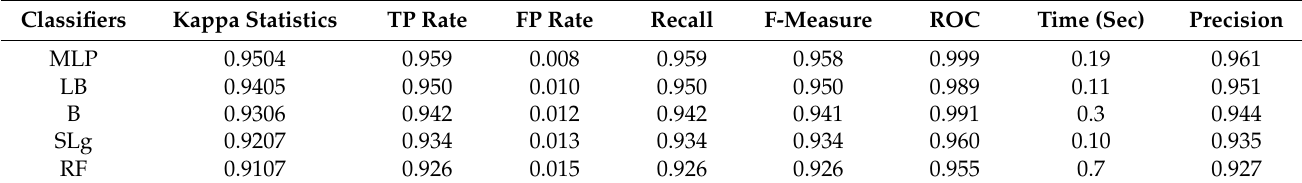
Table 3. Classification of medicinal plant leaves using five ML classifiers with ROO’s size of (220 × 220).